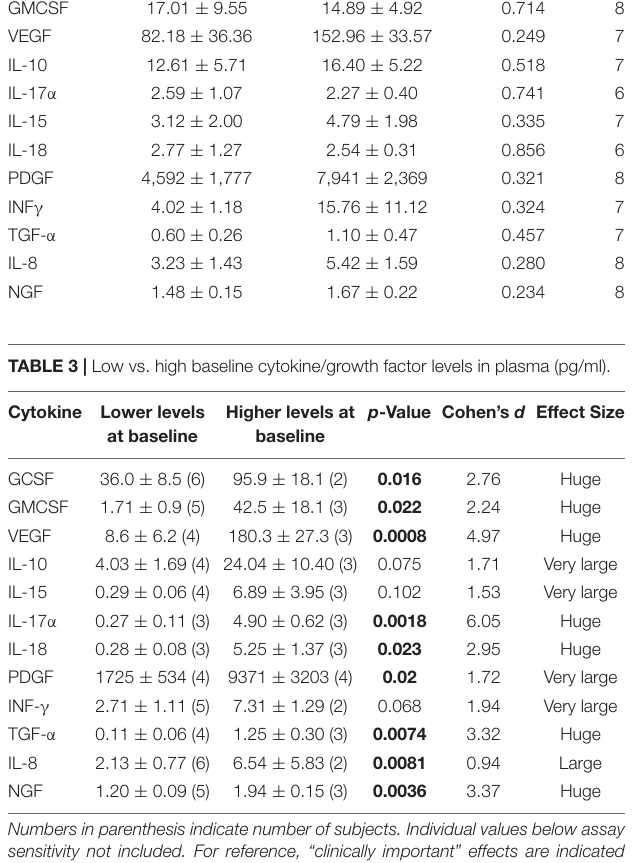
Numbers in parenthesis indicate number of subjects. Individual values below assay sensitivity not included. For reference, “clinically important” effects are indicated by Effect Size using the following established scale of Cohen’s d (Sawilowsky, 2009): moderate effect ( > 0.5), large effect ( > 0.8), very large effect ( > 1.2), and huge effect ( > 2.0). Bold values represent significant comparison of lower verses